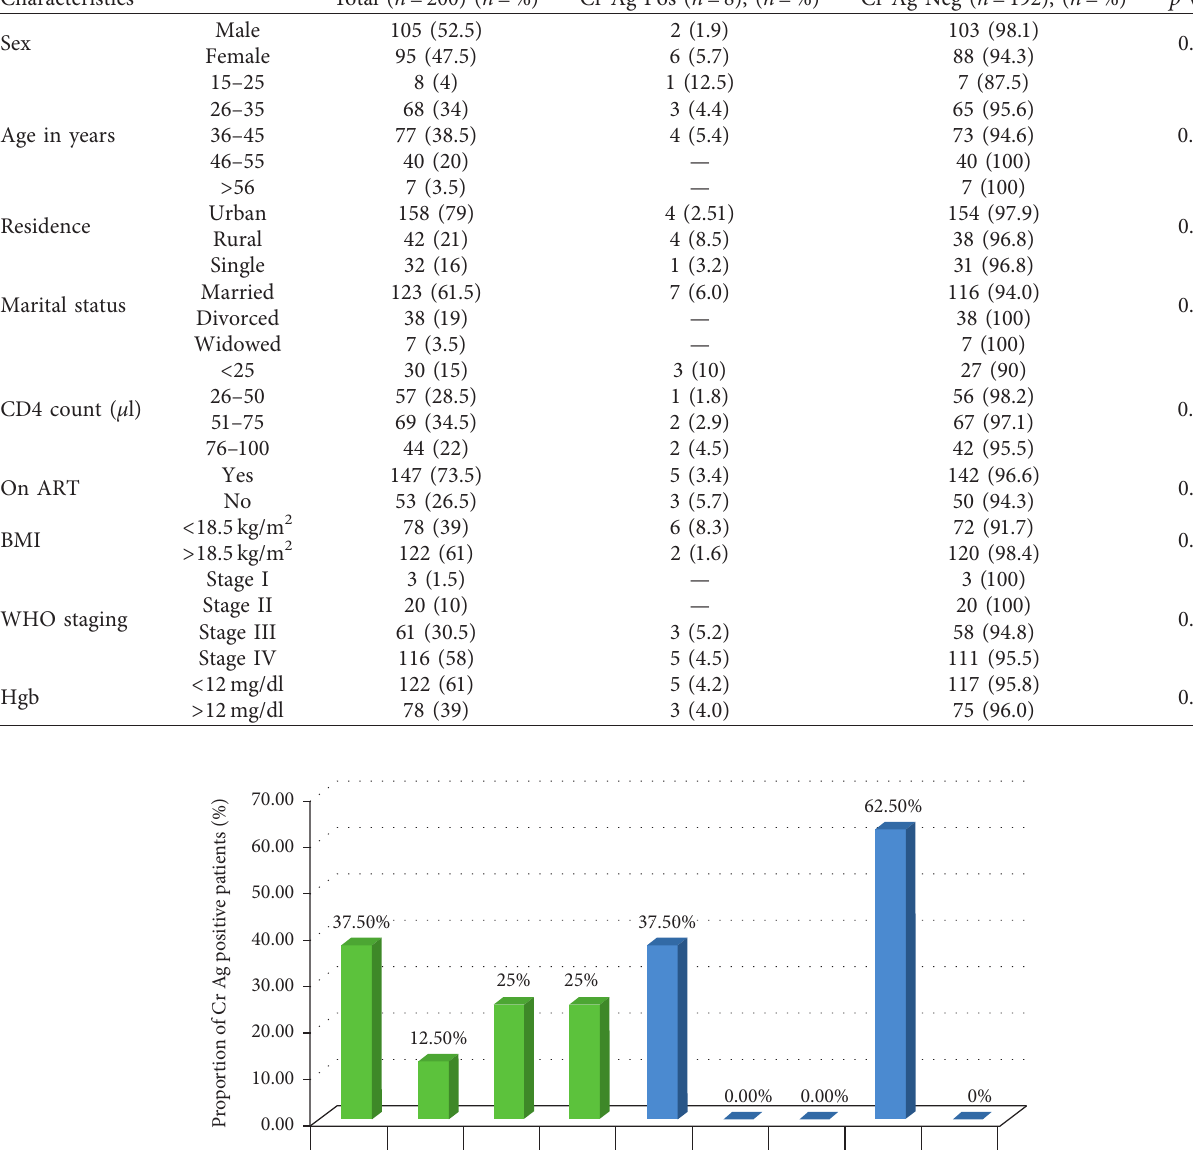
Table 1: Sociodemographic and baseline characteristics of study participants.